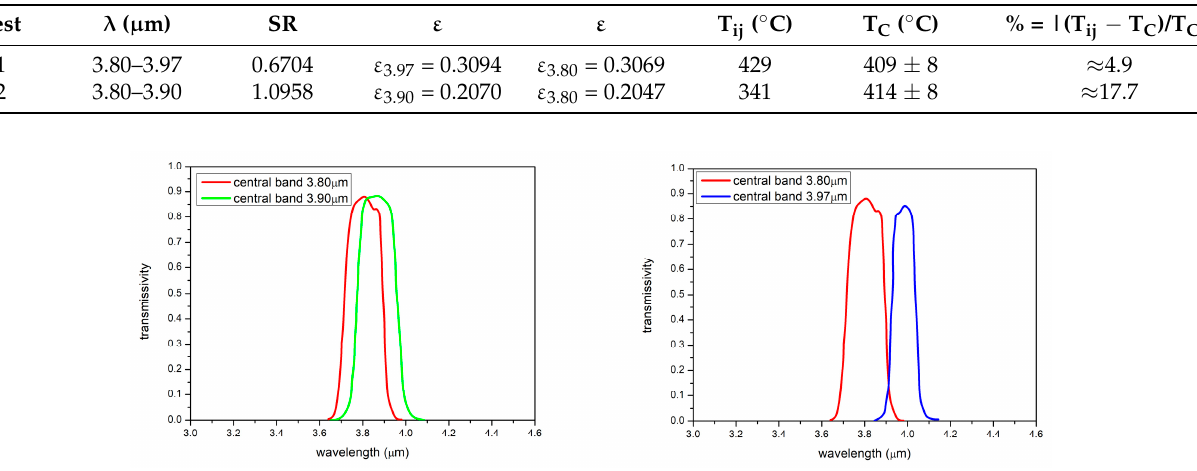
Figure 6. On the ( left ), the 3.80–3.90 µ m filters transmissivity curves are shown and, on the ( right ), the 3.80–3.97 µ m filters transmissivity curves are shown [5,6].